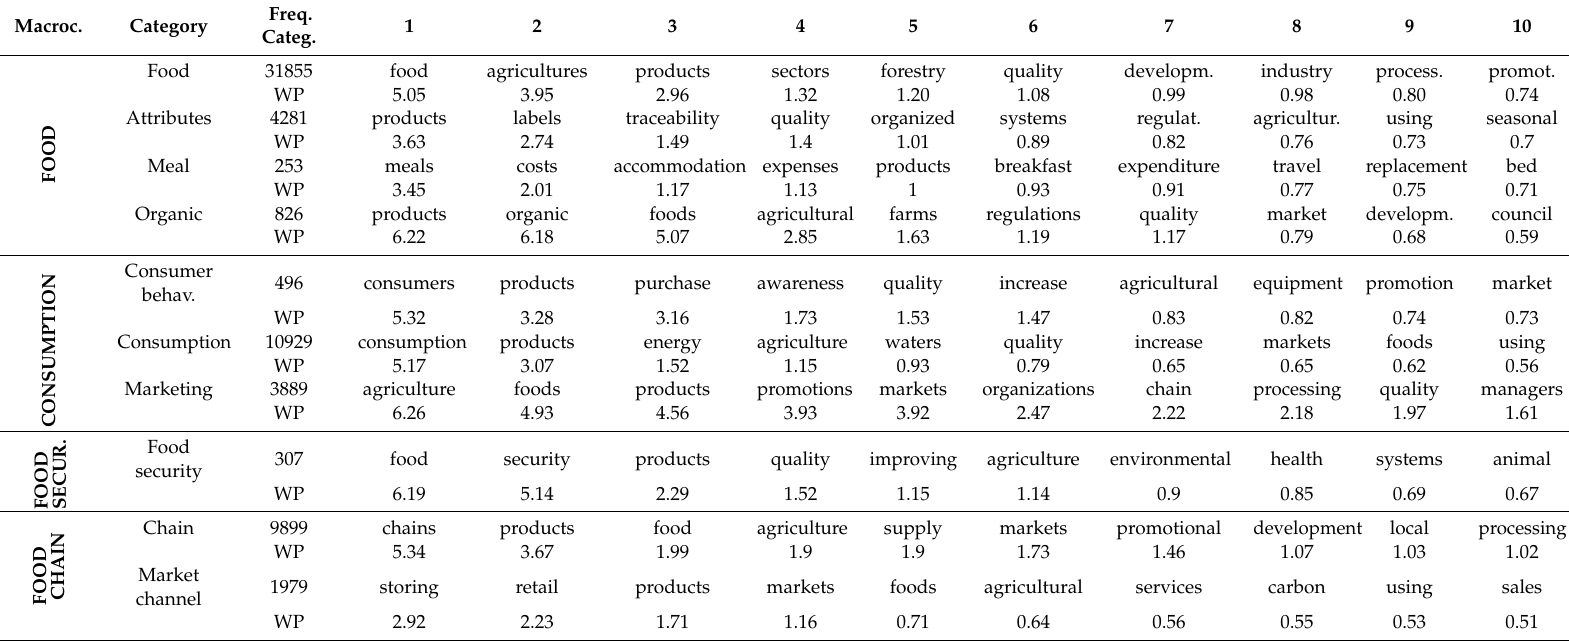
Table A7. Word frequency within single Food dimension